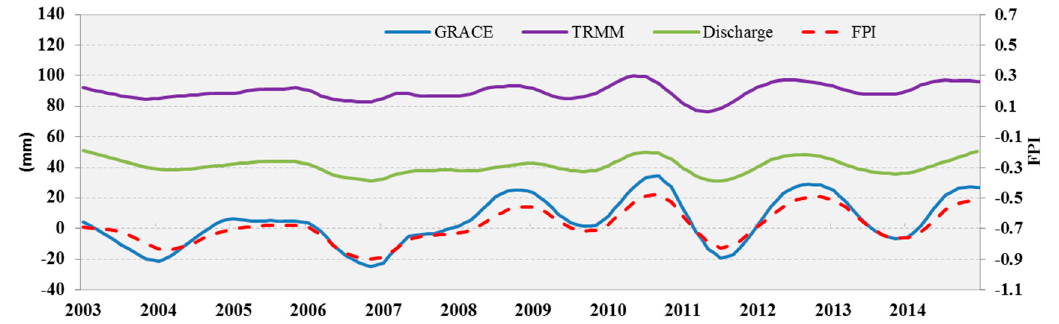
Figure 9. Time series of inter-annual variations of monthly rainfall from TRMM 3B43, GRACE-based TWSA, and monthly discharge from 2003-2014 in the Yangtze River Basin.